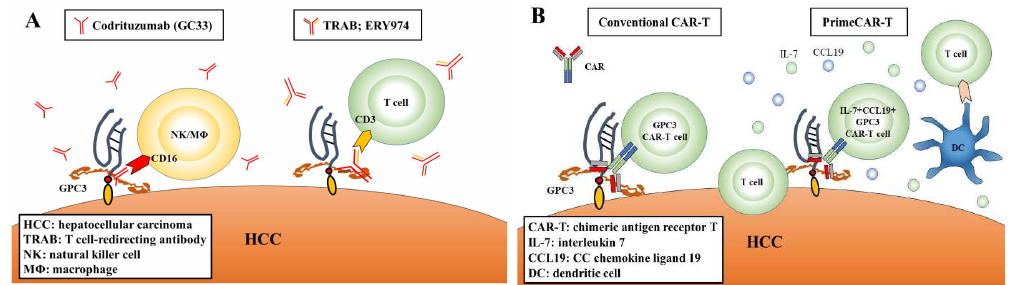
Figure 2. Schema of anti-tumor effect in immunotherapy. ( A ) Codrituzumab (GC33) induces ADCC by effector cells. TRAB (ERY974) further activates T cells. ( B ) Genetically engineered T cells navigated to glypican-3 (GPC3) are reinfused into patients in conventional CAR-T therapy. PrimeCAR-T has enhanced infiltration, accumulation, and survival capabilities in solid tumors.